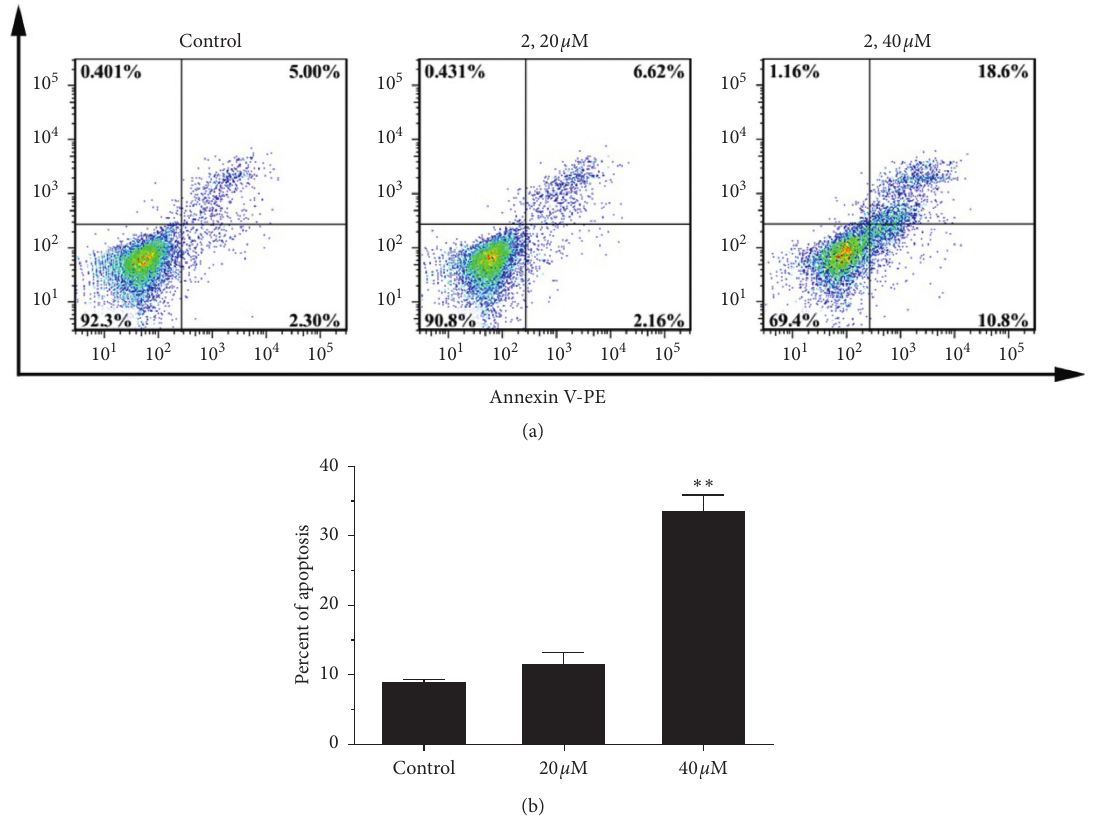
Figure 2: (a) Apoptosis of Eca-109 cells was detected by Annexin V-PE/7-AAD staining assay after coincubation with different con- centrations (0, 20, and 40 μ M) of complex 2 for 24h. (b) Quantitative data analysis for the number of cells (% of total) in apoptosis for different treatment groups. Data were presented as mean ± SD ( n � 3), Student’s t -test, ∗∗ P < 0 .